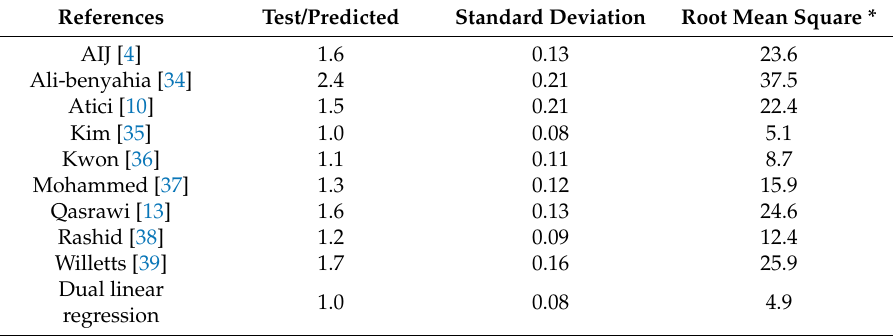
Table 6. Comparison results of compressive strength of concrete by rebound hammer test.